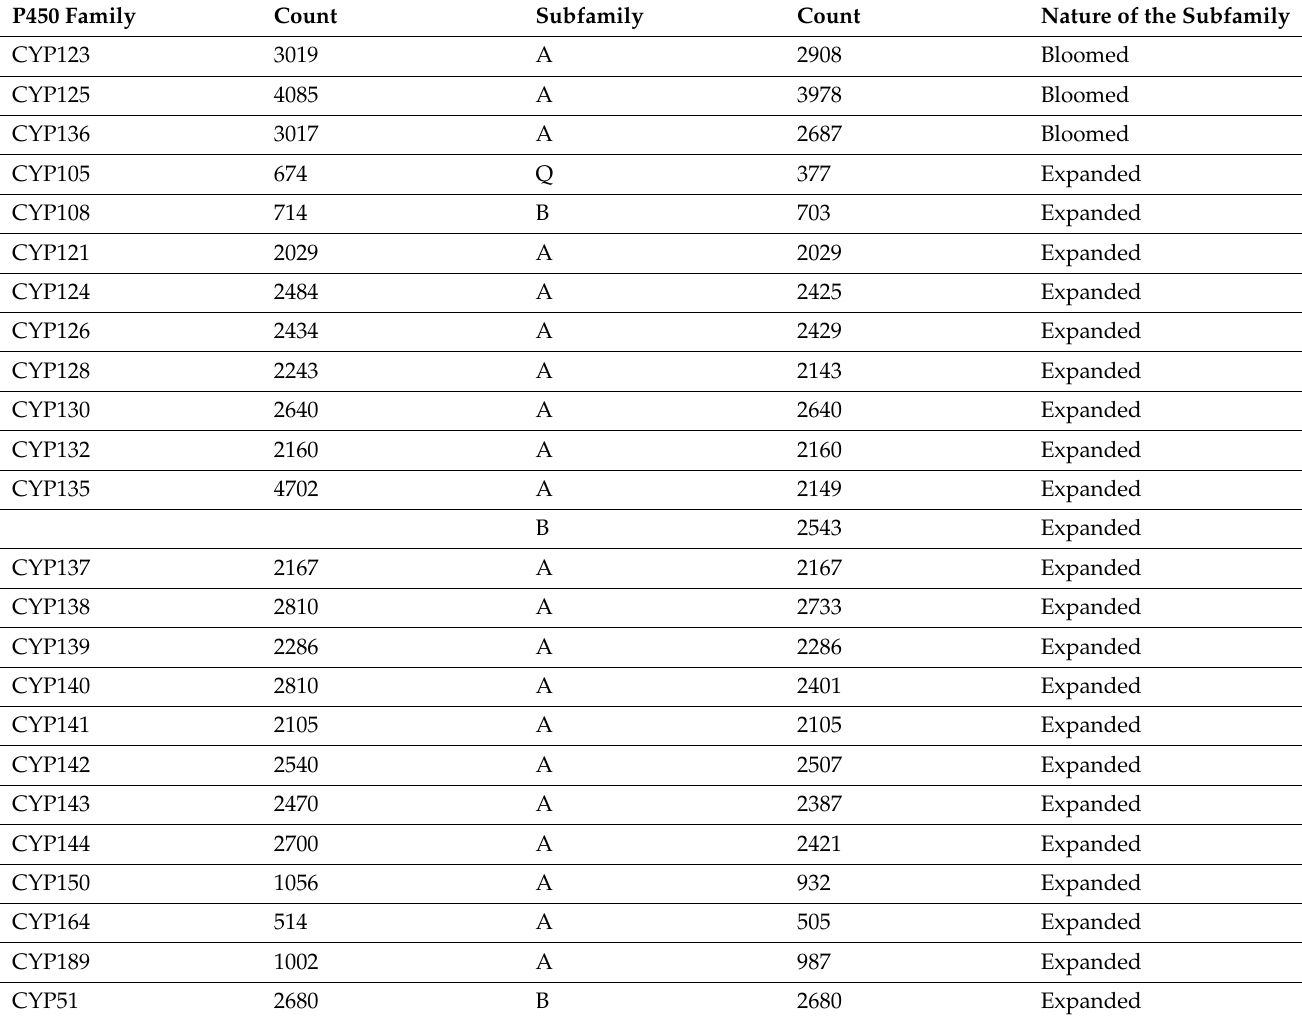
Table 3. Analysis of P450 subfamily blooming/expansion in mycobacterial species. Subfamily information for P450 families with >500 members is presented in the table, along with the nature of the subfamily (blooming/expansion). A detailed analysis of P450 subfamilies is shown in Table